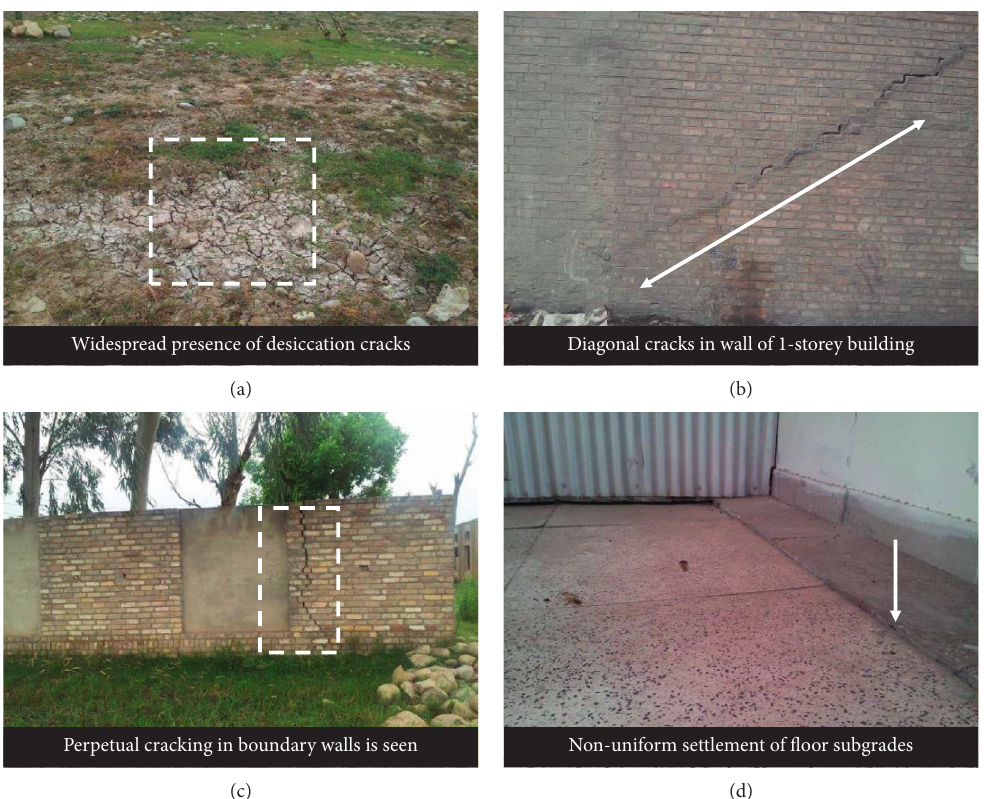
Figure 1: Variety of indicators of swelling clays in KPK province, north Pakistan. (a) Widespread presence of desiccation cracks. (b) Diagonal cracks in wall of 1-storey building. (c) Perpetual cracking in boundary walls. (d) Nonuniform settlement of floor